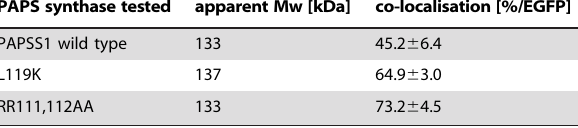
Table 1. Apparent molecular weight of PAPSS1